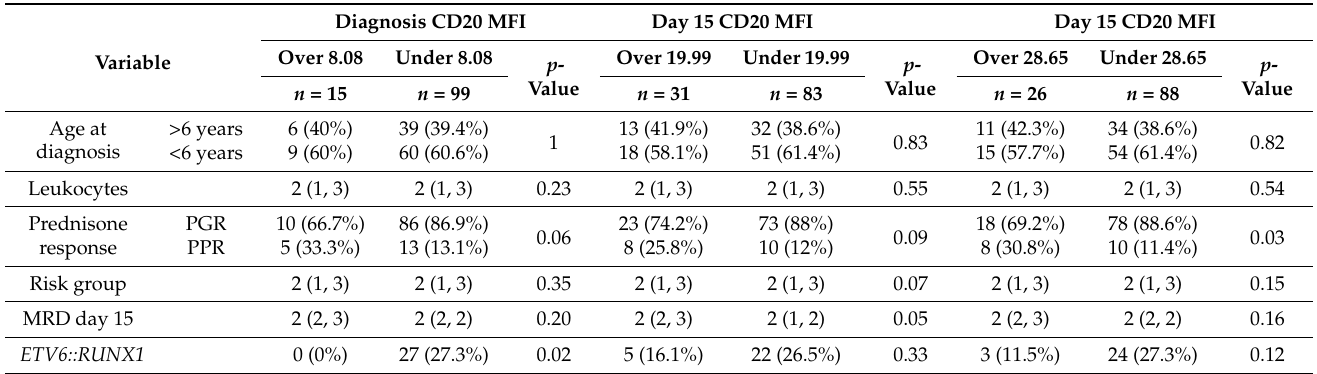
Table 3. Association between the groups formed by using the CD20 MFI cut-offs and variables observed to be predictive of RFS and OS.